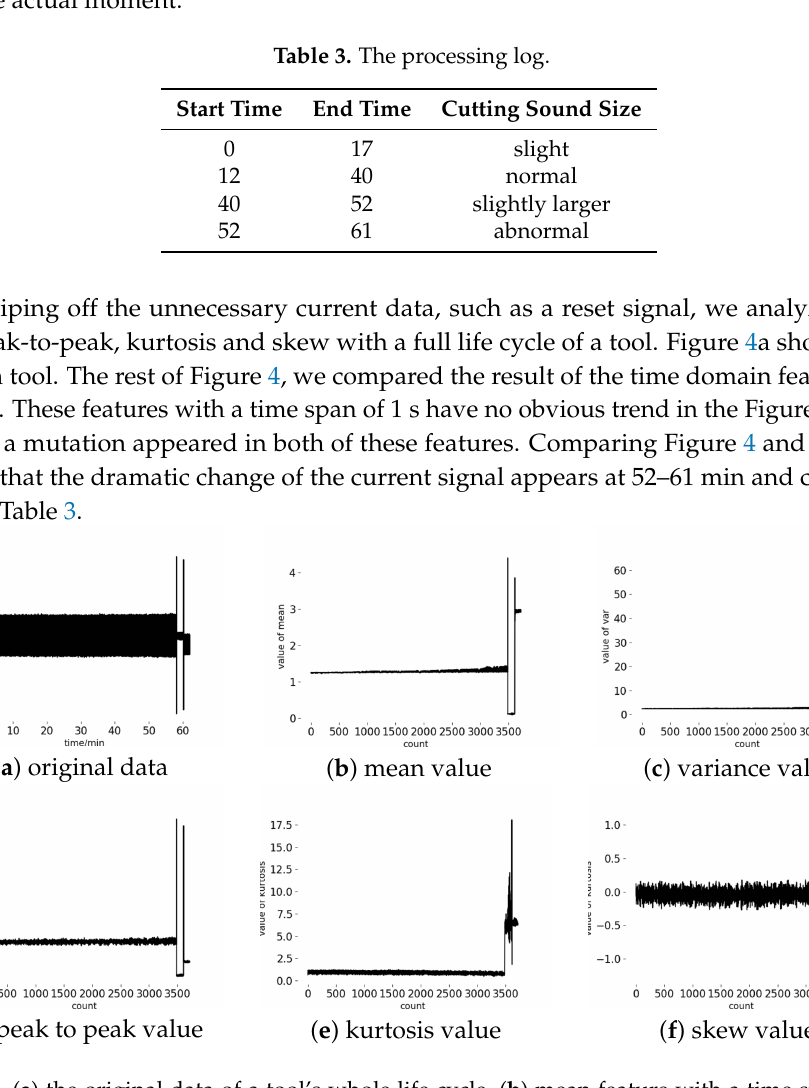
Figure 4. ( a ) the original data of a tool’s whole life cycle, ( b ) mean feature with a time span of 1 s, ( c ) variance feature with a time span of 1 s, ( d ) peak feature with a time span of 1 s, ( e ) kurtosis feature with a time span of 1 s, ( f ) skew feature with a time span of 1